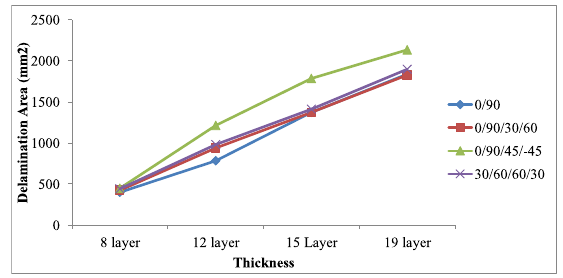
Figure 13. Delamination area on back face of plates for different lay-up and thicknesses.